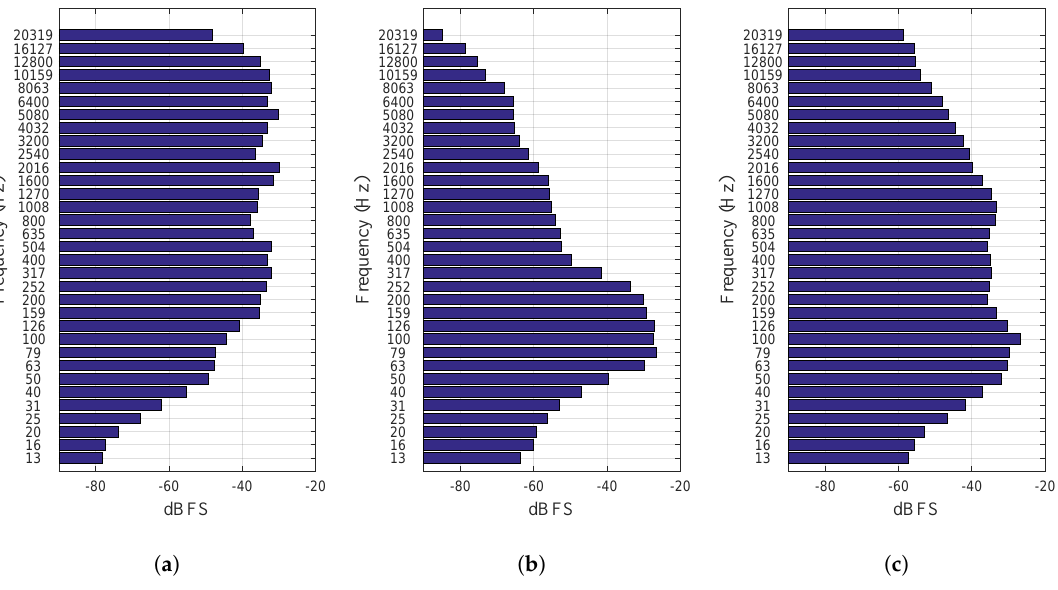
Figure 1. The spectrum of the three maskers in one-third octave bands: ( a ) Construction Work; ( b ) Car Engine; and ( c ) Heavy Traffic.